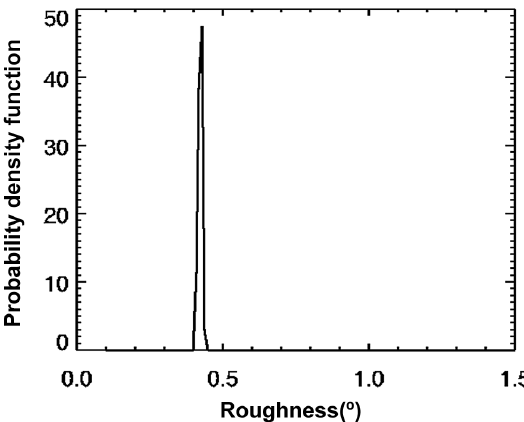
Figure 9. The a posteriori probability density function for the roughness parameter ¯ θ , noted P (cid:8) ¯ θ (cid:9) . The inverted value at 2 σ is ¯ θ = 0 . 424 ± 0 . 046 ◦ . The simulation corresponding with the highest likelihood is obtained for ¯ θ = 0 . 43 ◦